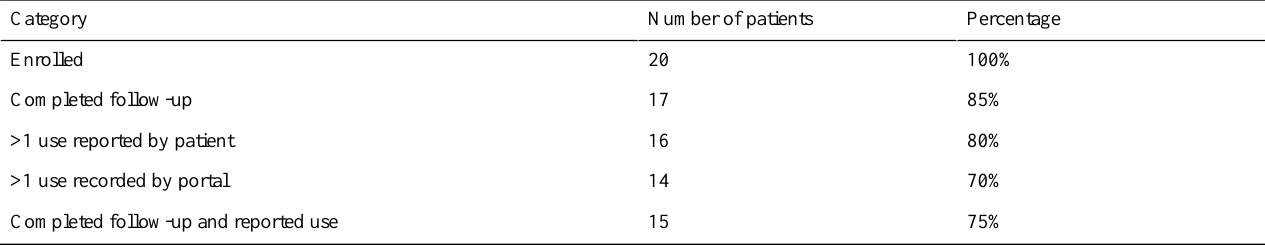
Table 3. Number of patients who used the app and responded to